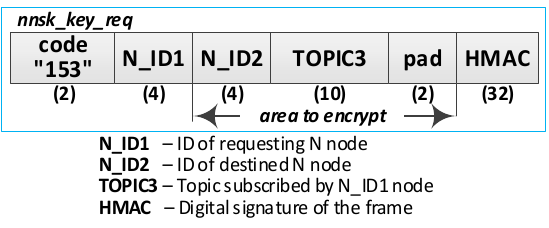
Figure 23. The session key request frame.